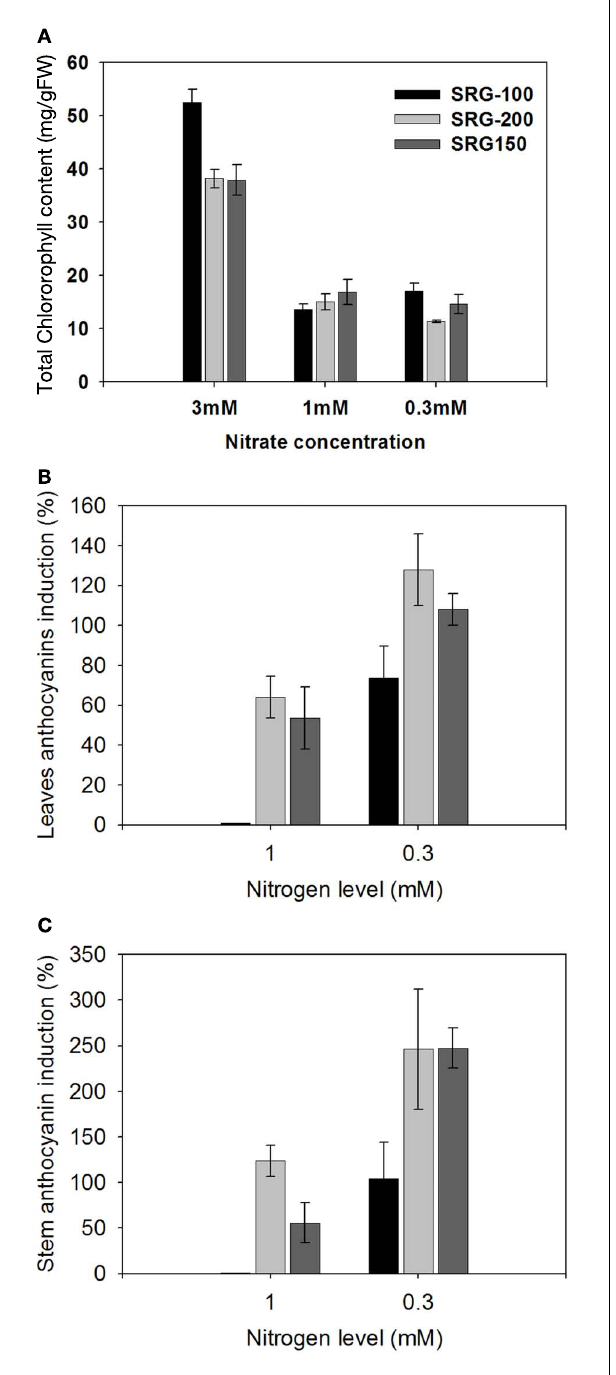
FIGURE 4 | N limitation effects on chlorophyll and anthocyanins content in the three genotypes; SRG-100 (black bars); SRG-200 (light gray bars); and SRG-150 (Dark gray Bars). (A) Total chlorophyll content (Chlorophyll a and b). Data are means ± SD ( n = 3 each replicate represent four plants). Bars with different letters indicate a significant difference at P , 0.05 (Tukey’s Honestly Significant DifferenceTest). (B,C) Induction percentage of the leaves and stem anthocyanins in the plants growing under N limitation relative to the plants of the same genotype growing optimal nitrogen level (3mM). Data are means ± SD ( n =